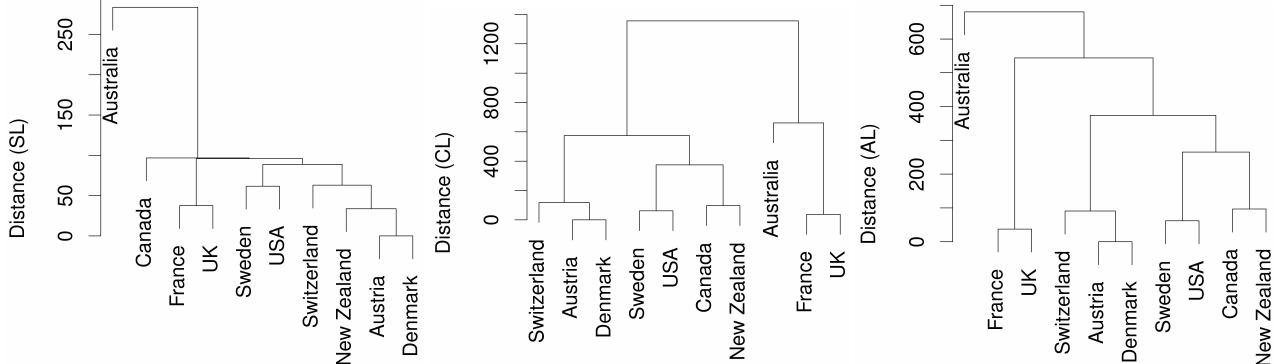
Figure 1. Dendrograms for between-cluster distances (left: single linkage, mid: complete linkage, right: average linkage) based on mortality data for males aged 53 to 87 in 10 countries between 1948 and 1987 (note the differing